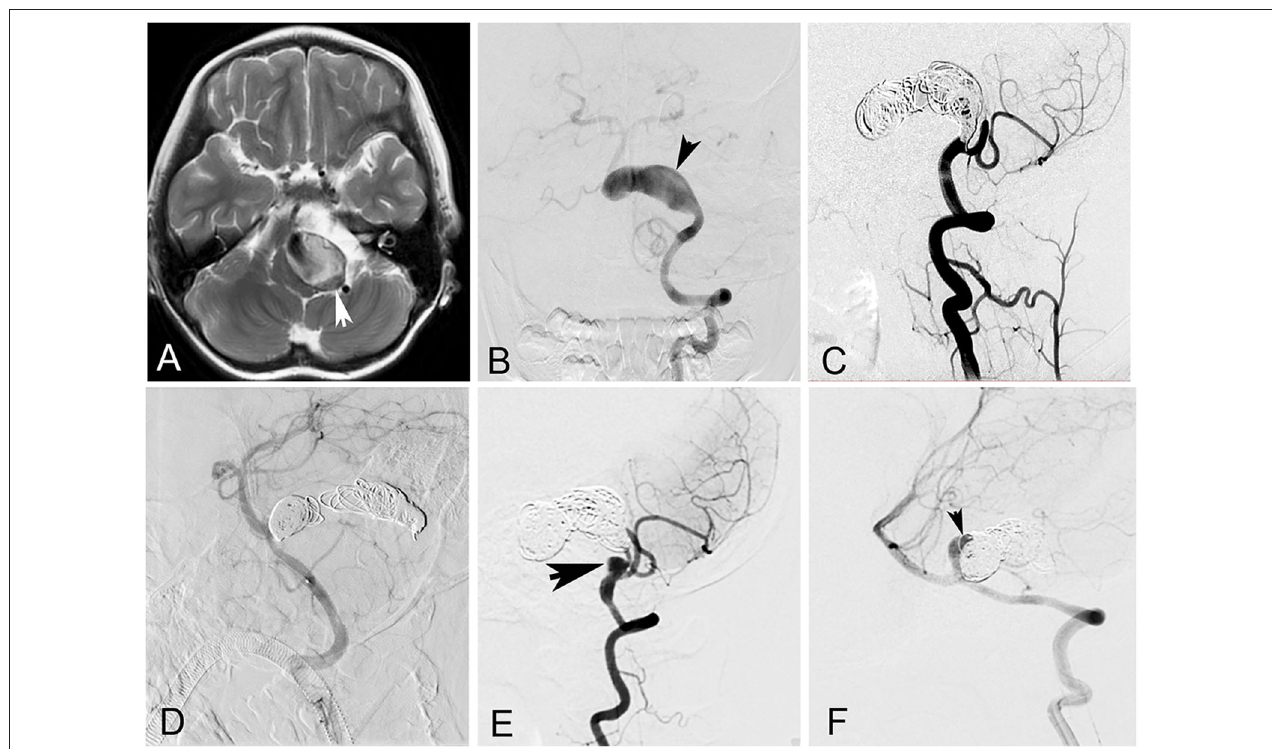
FIGURE 2 | A 6-year-old girl with a giant vertebrobasilar dissecting aneurysm. (A) Magnetic resonance imaging showed a giant vertebrobasilar dissecting aneurysm with intramural hematoma. (B) Left vertebral anteroposterior angiogram revealed the aneurysm. (C) Left vertebral artery and the aneurysm were occluded with coils at lateral angiogram. (D) Right vertebral was patency after the procedure at lateral angiogram. (E,F) Left and right vertebral lateral angiogram at follow-up showed the aneurysm recanalized